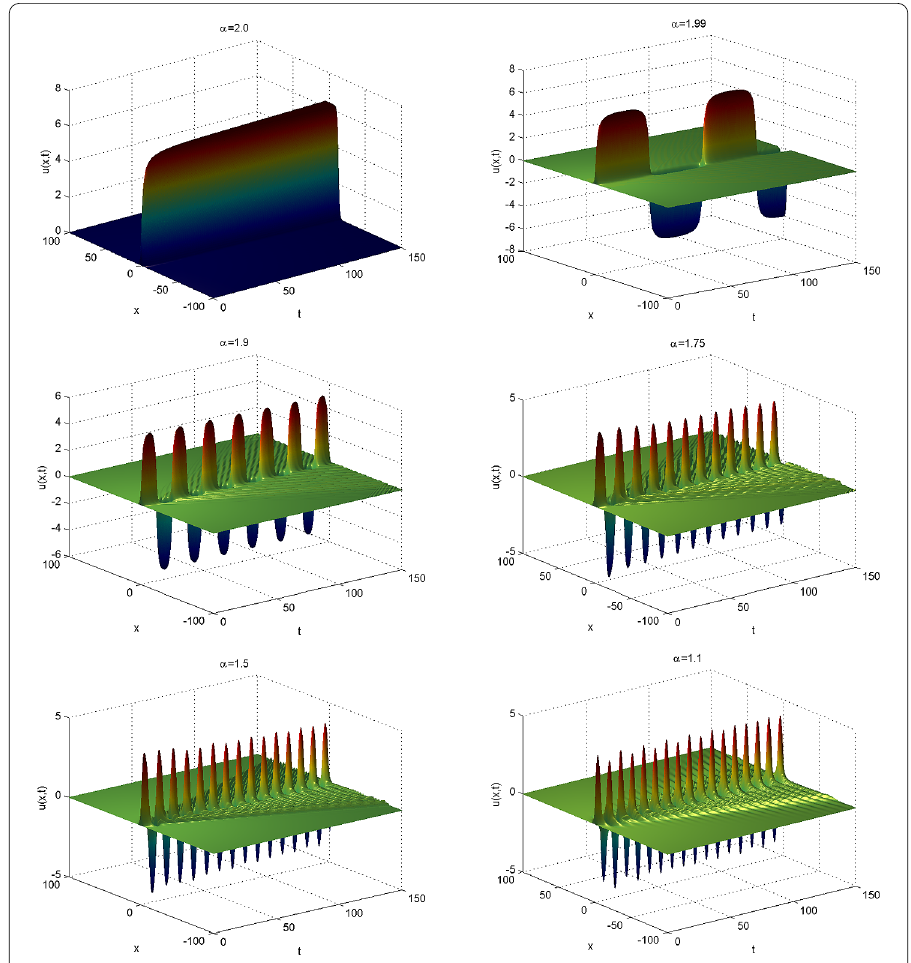
Figure 2 Approximate solution of the initial boundary value problem in Example 1 with various orders α with h = 1/10 and τ =